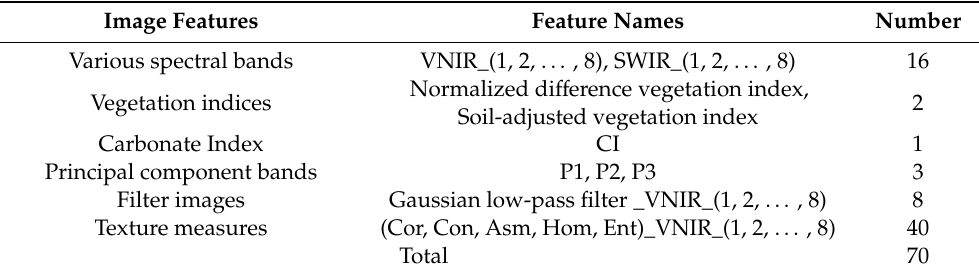
Table 2. Details of the feature set used in this study.